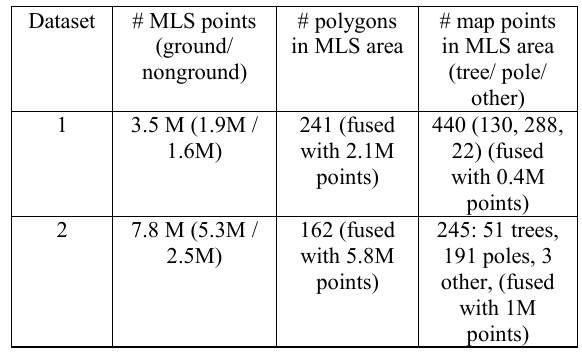
Figure 6 MLS points of dataset 2 classified by polygon based fusion, colored by object_id (top) and class_id (bottom): buildings [white], road [cyan], terrain [red], and water [blue, hardly visible].